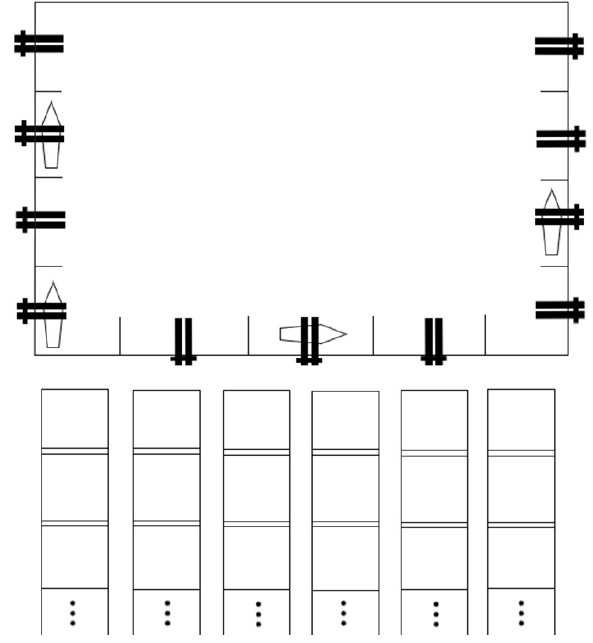
Figure 2. Layout of the berths and